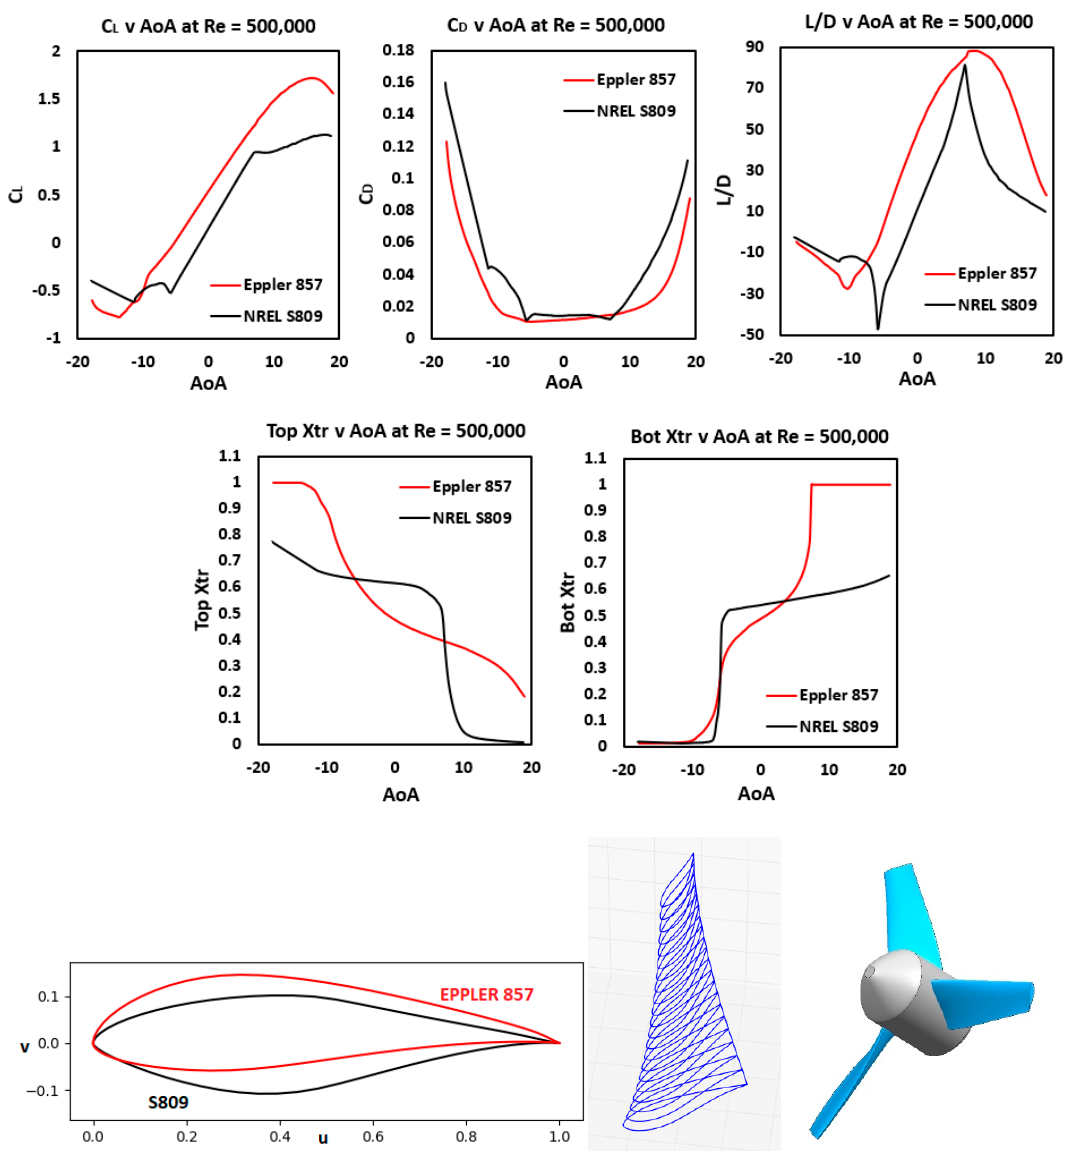
Figure 38. Eppler 857 hydrofoil compared with S809 and 3D blade for hydrokinetic turbine.